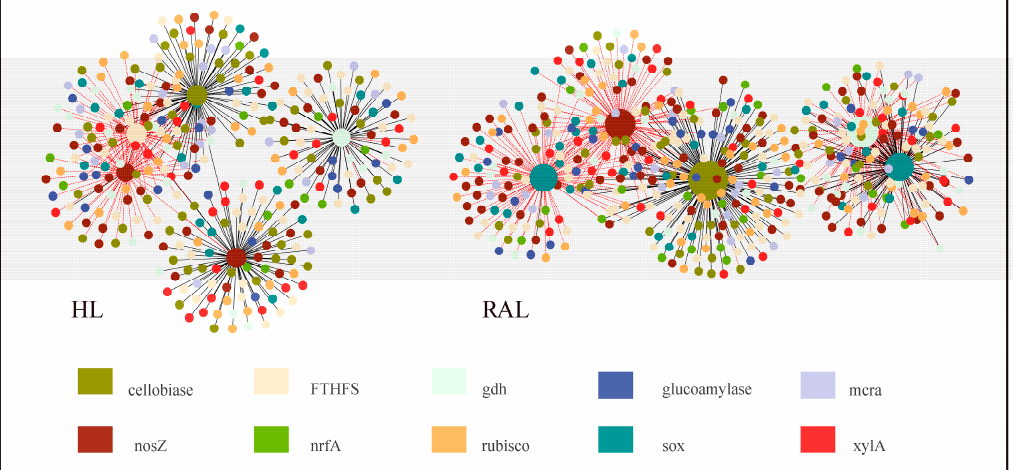
Figure 4. Differences in the network topology of key functional genes and the connectivity of the top five ranked genes in the HL and the RAL. The colors of the nodes indicate different functional genes. The solid black line indicates a positive relationship between the two nodes, and the short-dotted red line indicates a negative relationship. The size of each node is proportional to the number of connections (degrees).